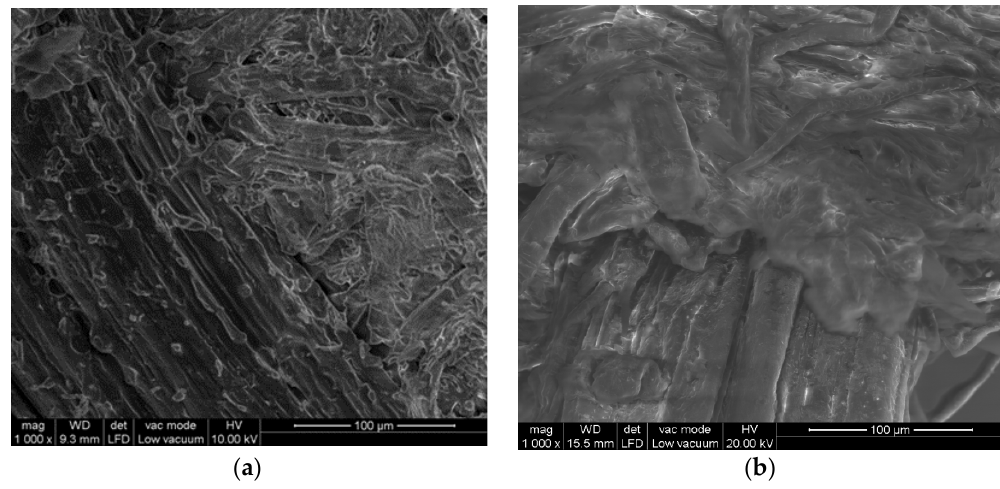
Figure 1. Microscopic images. Material with ( a ) and without ( b ) final heat treatment.